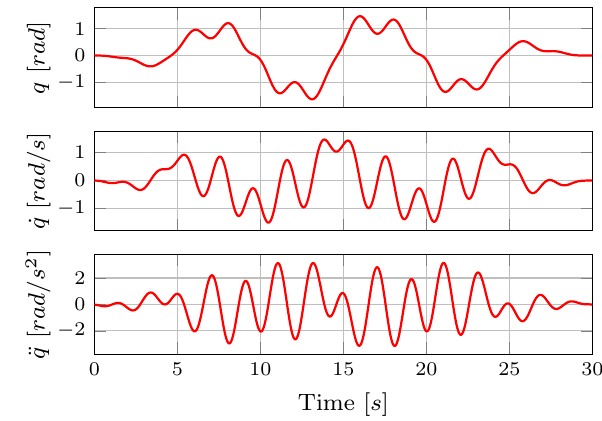
Fig. 9 Exemplary identification trajectory for a single joint result- ing from the experiment optimization based on Fourier series. One period (10s) to fade-in from the initial position has been pre- pended, and one period to fade-out to the final position has been